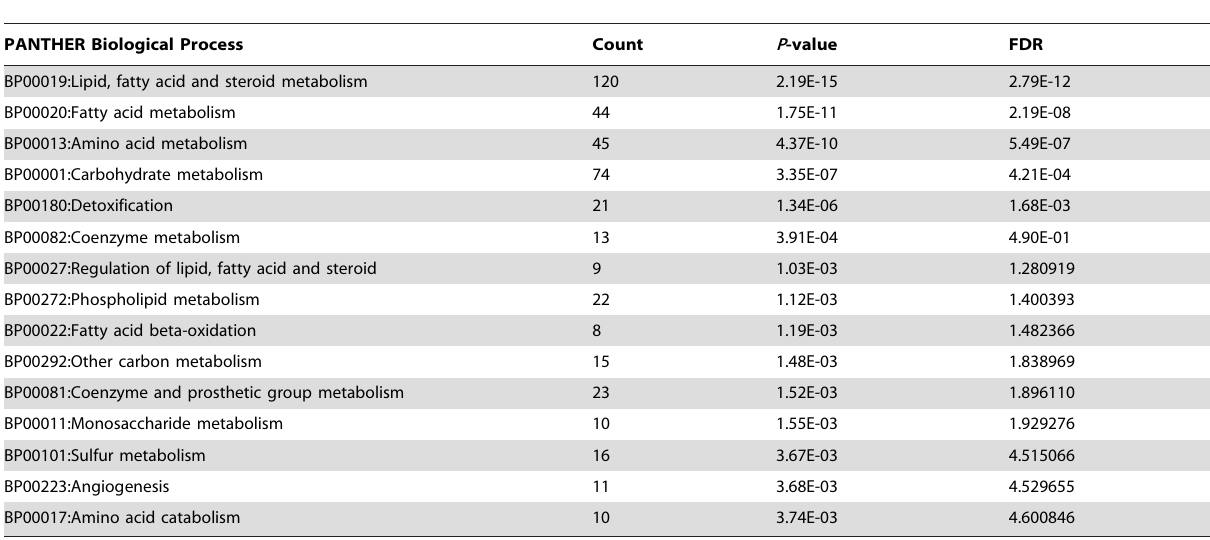
Table 1. Summary of PANTHER GO analysis for ROR c target genes.